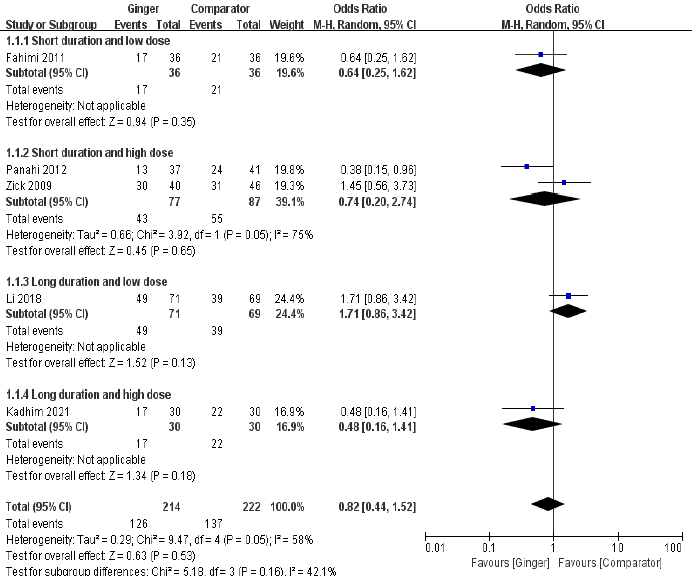
Figure 2. Effects of ginger intake on chemotherapy-induced acute nausea. Short duration ≤ 4 days; Long duration > 4 days; Low dose ≤ 1 g/day; High dose > 1 g/day. Fahimi 2011 [19], Panahi 2012